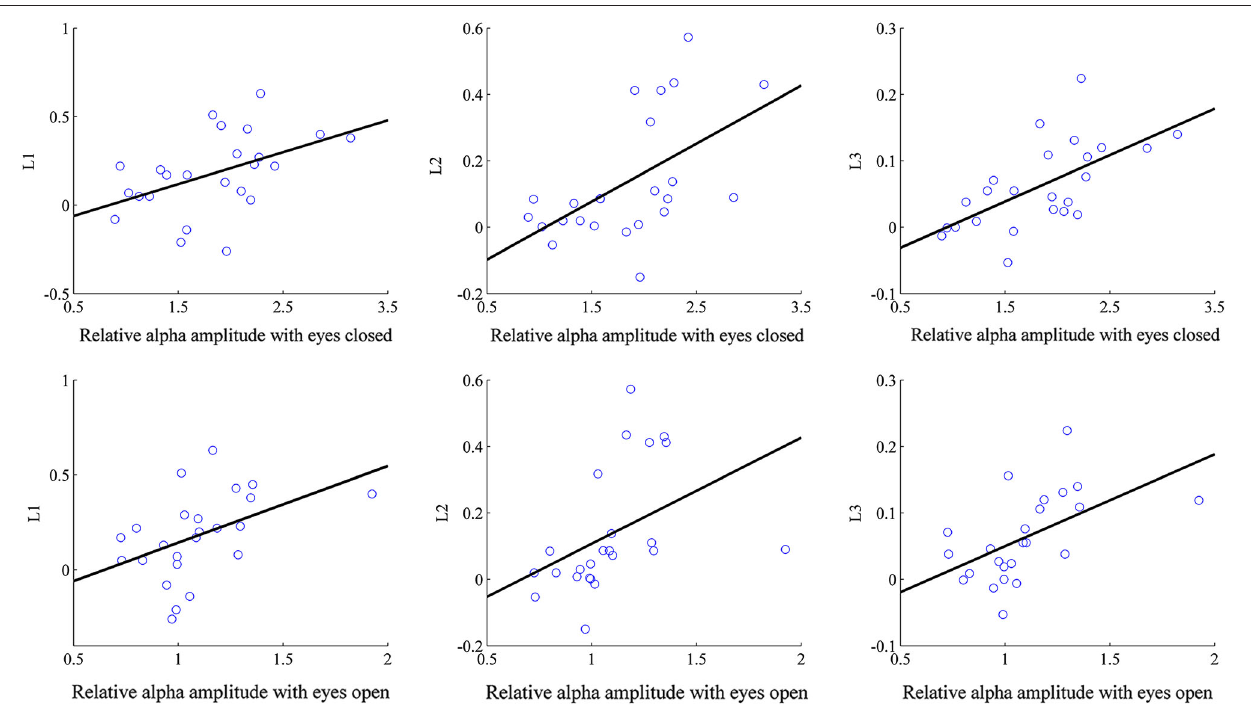
FIGURE 4 | Correlation of the eyes-closed/eyes-open resting alpha amplitude with the learning indices . Each circle corresponds to one subject.